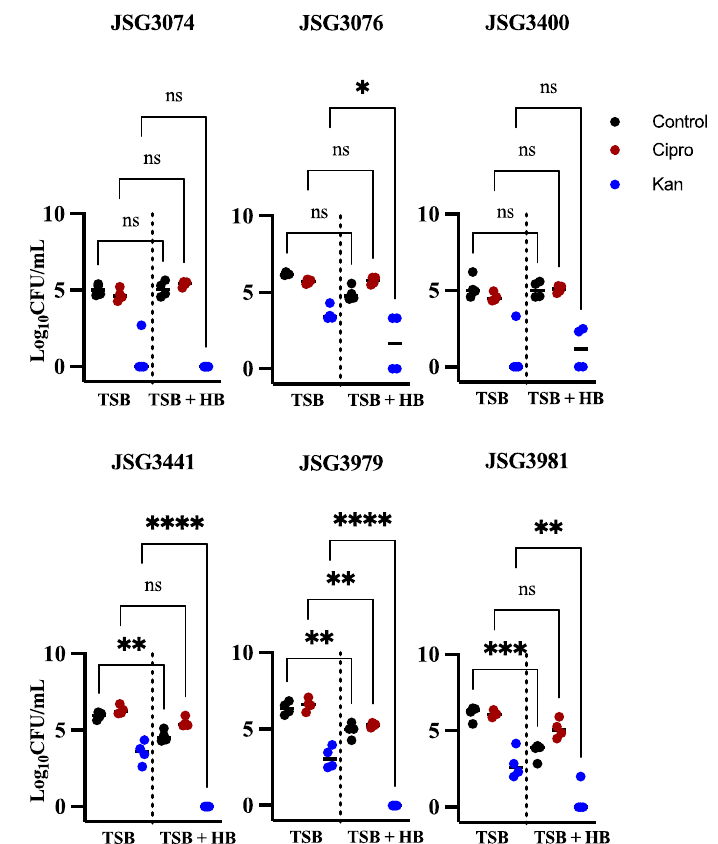
Figure 3. Persister cells recovered in S . Typhi clinical strains after treatment with ciprofloxacin (red circles) or kanamycin (blue circles) in biofilms on human bile versus total cells (strains not treated with antibiotics are represented by black circles). Representative charts are shown from one experiment performed with four or more biological replicates and repeated at least three times with similar results. A one-way ANOVA followed by Tukey’s multiple-comparison test were used to compare the different conditions (ns, not significant; *, p ≤ 0.05; **, p ≤ 0.01; ***, p ≤ 0.001; ****, p ≤ 0.0001).